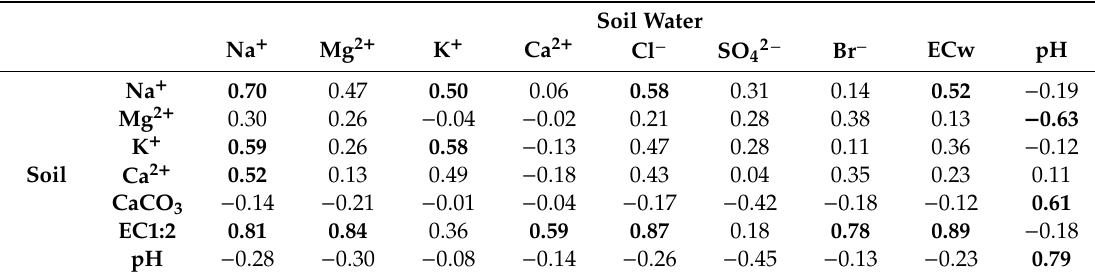
Table 5. Spearman’s correlations between soil and soil water chemical properties. Values range from − 1 to + 1 with larger absolute values indicating a stronger relationship. Bold values indicate significant correlations ( α = 0.05).